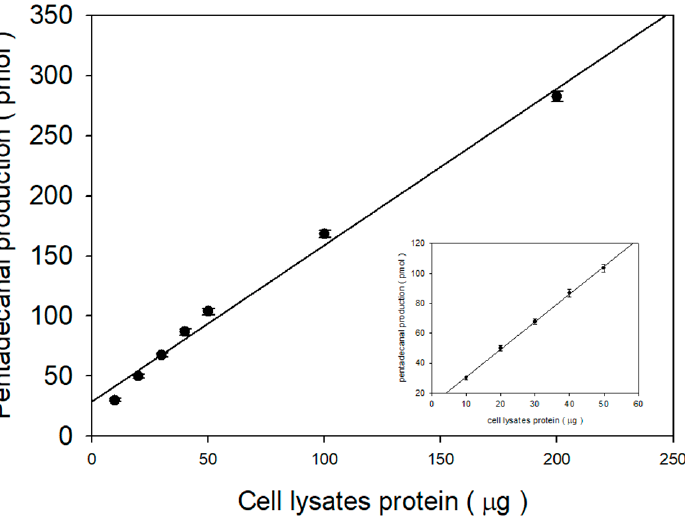
Figure 6. Linearity of the S1PL reaction at higher protein concentrations after applying a correction for biotransformation. We performed the response for 20 min with 20 µ M C17 Sa1P as the substrate and variable amounts of F9-4 cell lysate proteins. The 200 µ L volume of ethanol stopped the pentadecanal production reaction. For the derivatization reaction, we added the 5,5-dimethyl CHD solution with 100 pmol of heptadecanal as the internal standard. Aldehyde-5,5-dimethyl CHD was extracted via solid-phase extraction and analyzed using C18 reverse-phase HPLC–FLD. The insert shows expanded views of the data generated at high cell lysate protein concentrations. The data represent the mean ± SD of triplicate